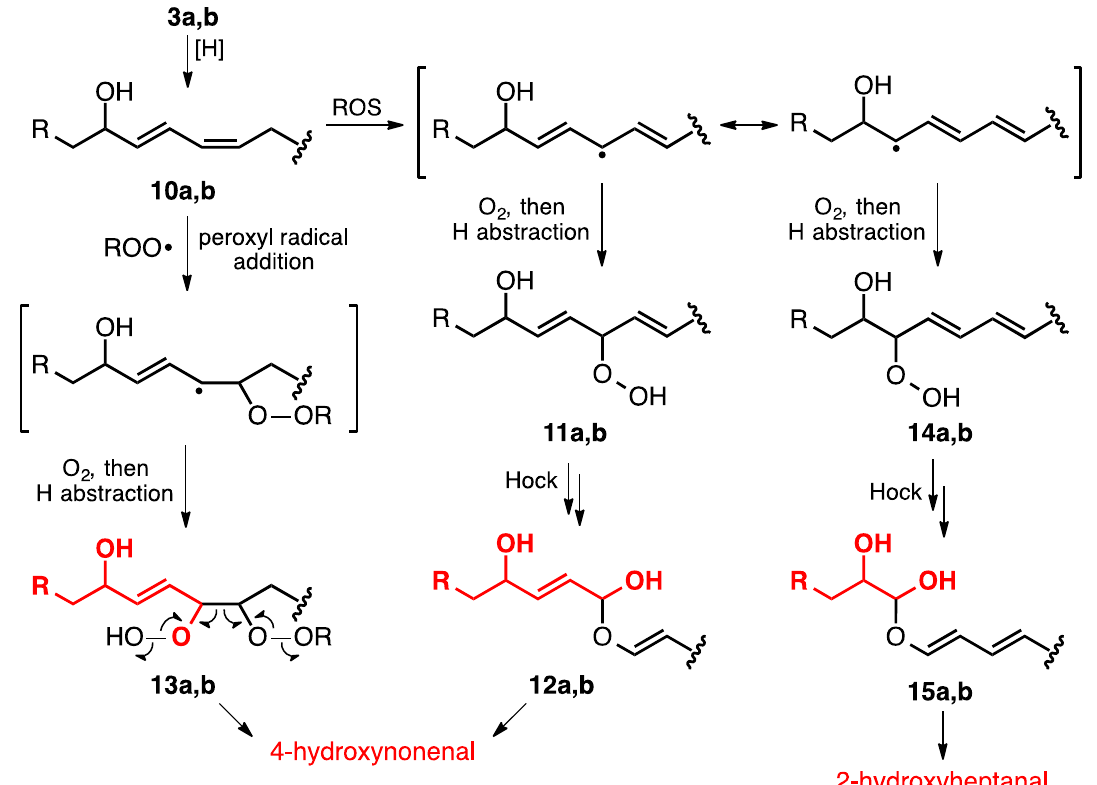
Figure 3. Bis-peroxidation pathways leading to the formation of 2- and 4-hydroxyaldehydes. Atoms in red give rise to the aldehydes generated by the indicated processes.